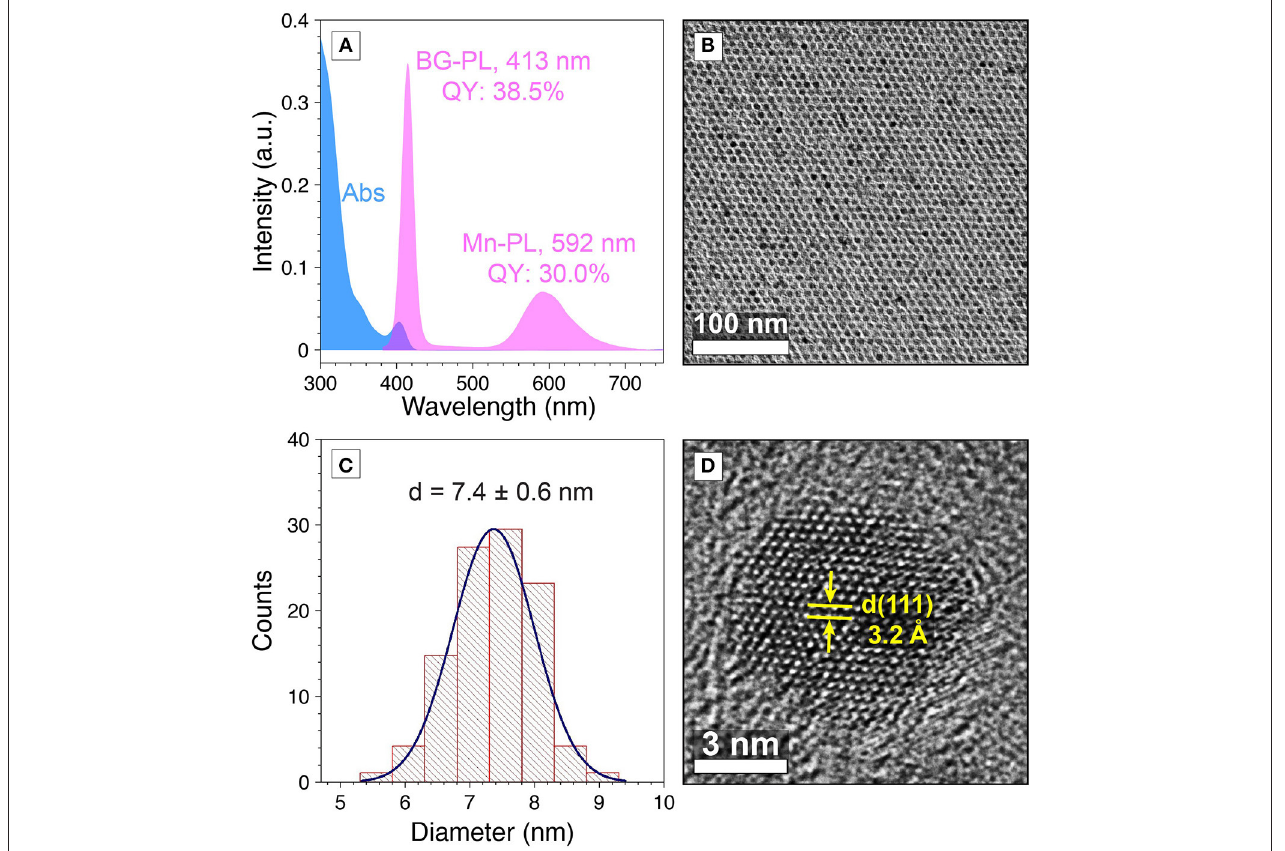
FIGURE 3 | (A) Absorption (blue) PL (pink) spectra, and (B) TEM image of Mn-doped CdS-ZnS core-shell QDs. (C) Size distribution histogram of Mn-doped CdS-ZnS core-shell QDs. (D) HR-TEM image for a Mn-doped CdS-ZnS core-shell QD.